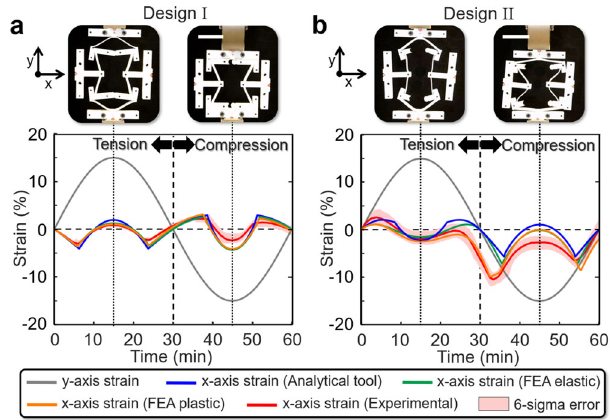
Fig. 5 Comparisons between the analytical MATLAB tool, elastic and plastic fi nite element analysis (FEA) simulations, and experimental test results for a Design I and b Design II unit cells. Scale bars in a and b ,